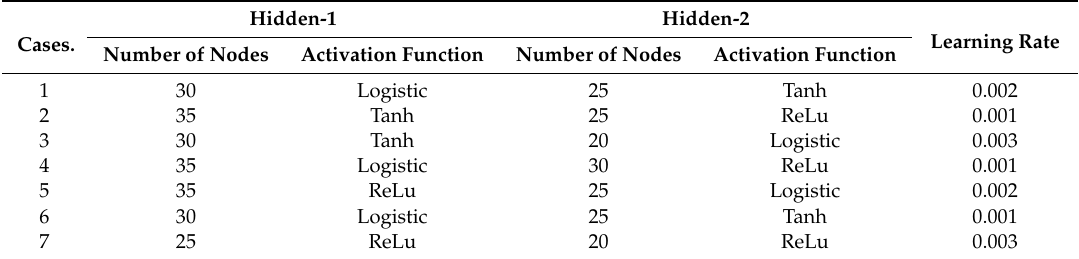
Table 3. Conditions of the hidden node for developing a phosphate ion prediction model through ANN.